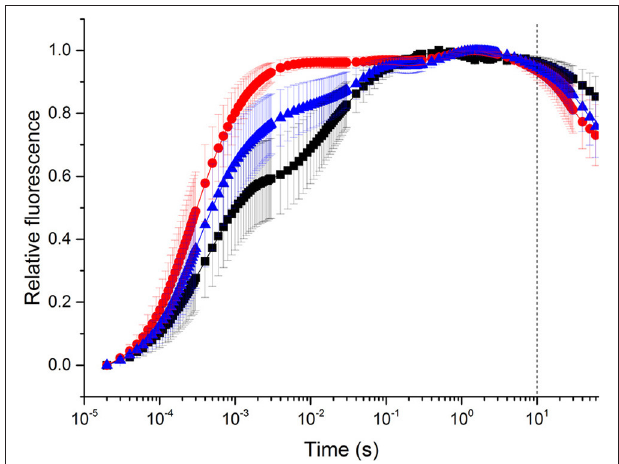
FIGURE 8 | Fast fluorescence induction (OJIP) curves. Measurements were done at 25 ◦ C (control, black line), at 33 ◦ C (heat, red line), and 25 ◦ C after the heat treatment (recovery, blue line). Illumination was applied from the beginning of data recording; the dashed line represents the timepoint when the illumination was turned off. Fluorescence traces are double-normalized ( F o set to 0 and F m to 1) in order to represent relative changes. Error bars are standard errors of mean (SEM), n =